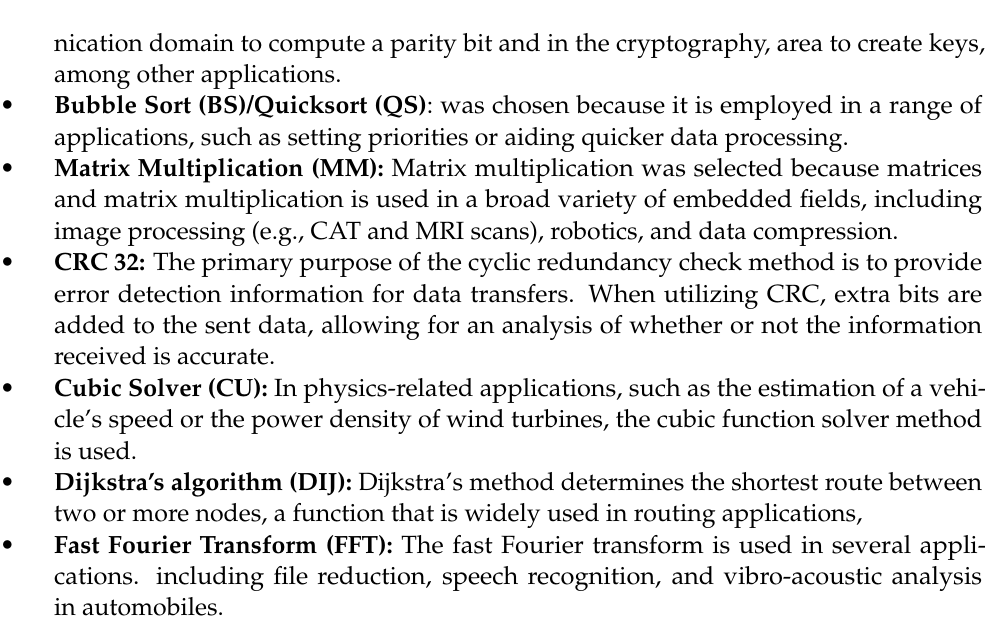
Table 3. The selected registers to protect for each academic case